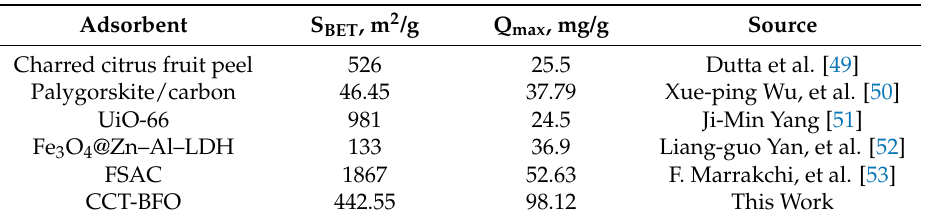
Table 3. The maximum adsorption capacity of various adsorbents for MB.